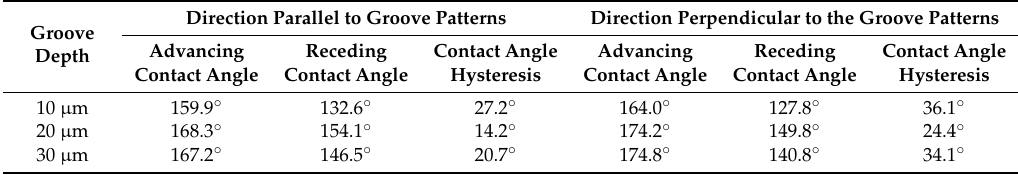
Table 2. Contact angle hysteresis results on the groove pattern surfaces with